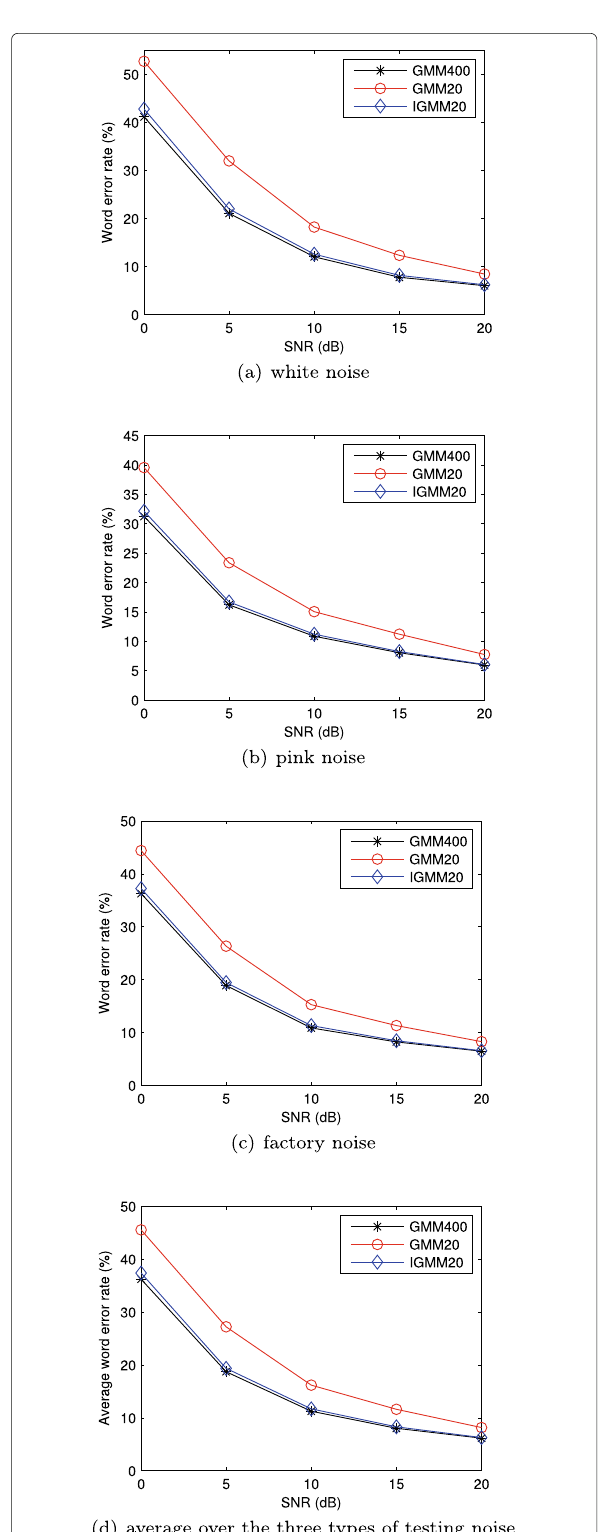
Fig. 4 Performance comparison of the proposed algorithm (IGMM20) and original GMM-based feature compensation (GMM400 and GMM20) with different SNRs for the three types of testing